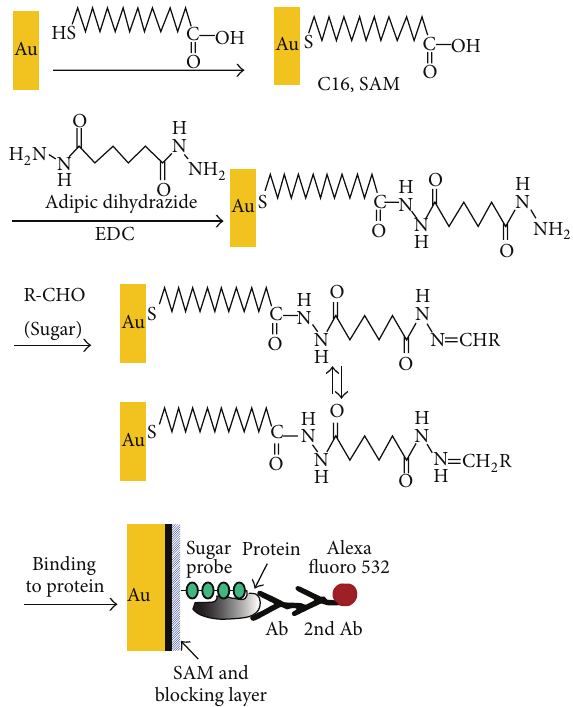
Scheme 9: Application of hydrazide-derivatized SAM on a gold surface for the fabrication of oligosaccharide microarray (adapted from [39]).